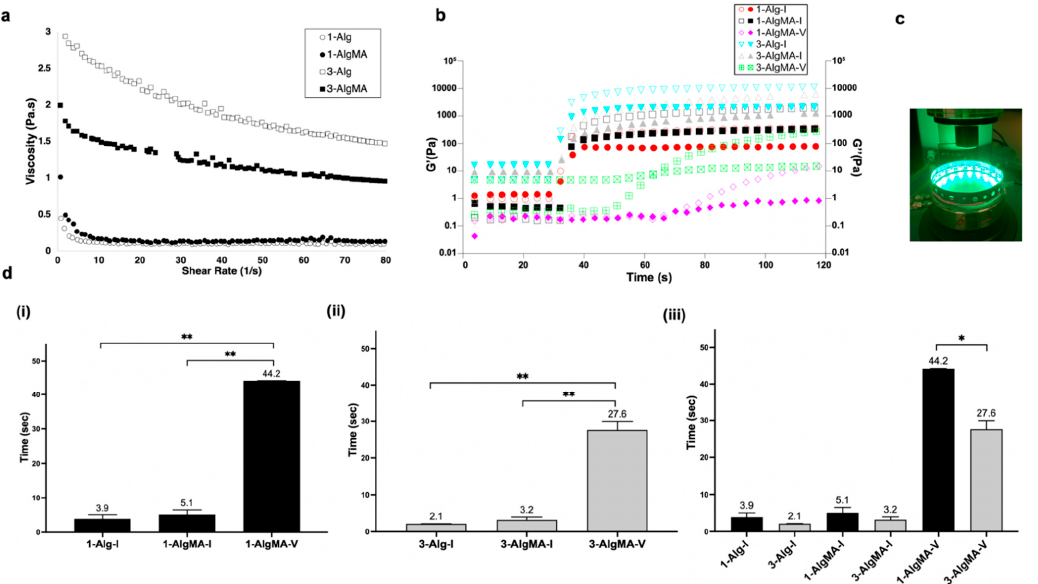
Figure 3. ( a ) Viscosity values versus shear rate for 1 and 3% ( w / v ) Alg and AlgMA aqueous solutions. ( b ) Representative curves of storage (G ′ ) and loss (G ″ ) moduli for ionically crosslinked and photo- crosslinked 1 and 3% ( w / v ) Alg and AlgMA solutions. Hollow markers indicate G ′ values, whereas solid markers indicate G ″ values. The crossover of G ′ and G ″ indicates the initiation of crosslinking of the material to form an elastic component of the hydrogel. The crosslinking process (CaCl 2 or green light) was initiated 30 s after the start of the test. ( c ) The gelation kinetics for photo- crosslinking were performed on a rheometer with a custom green light setup. ( d ) Gelation times for ionically crosslinked Alg and AlgMA materials and photo-crosslinked AlgMA materials; significant differences were calculated within the ( i ) 1% ( w / v ) and ( ii ) 3% ( w / v ) hydrogel groups, respectively, and between the ( iii ) 1 and 3% ( w / v ) hydrogel groups (* p < 0.05, ** p < 0.005).